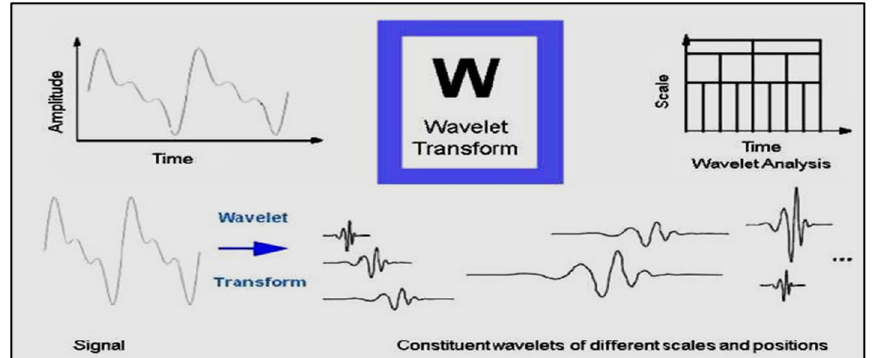
Figure 10. Wavelet transform.